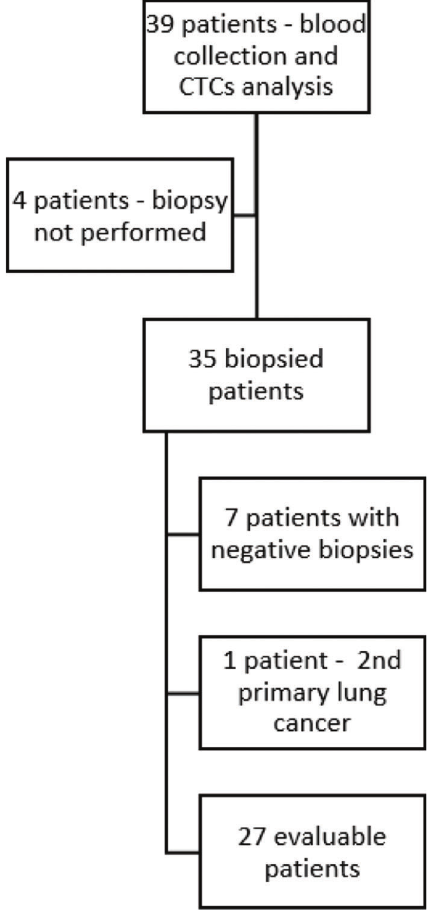
Figure 1 - Flowchart showing patient inclusion, blood collection, biopsies, and reasons for excluding patients. Abbreviations: CTCs (circulating tumor